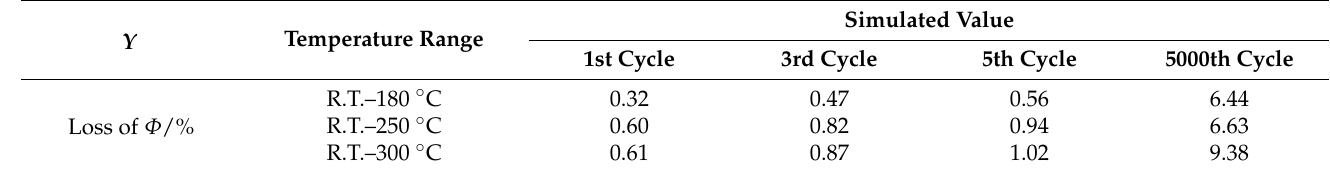
Table 3. Simulation values of the losses of Φ in the different temperature range for the 1st, 3rd, 5th, and 5000th cycles, using the fitting parameters as shown in Table